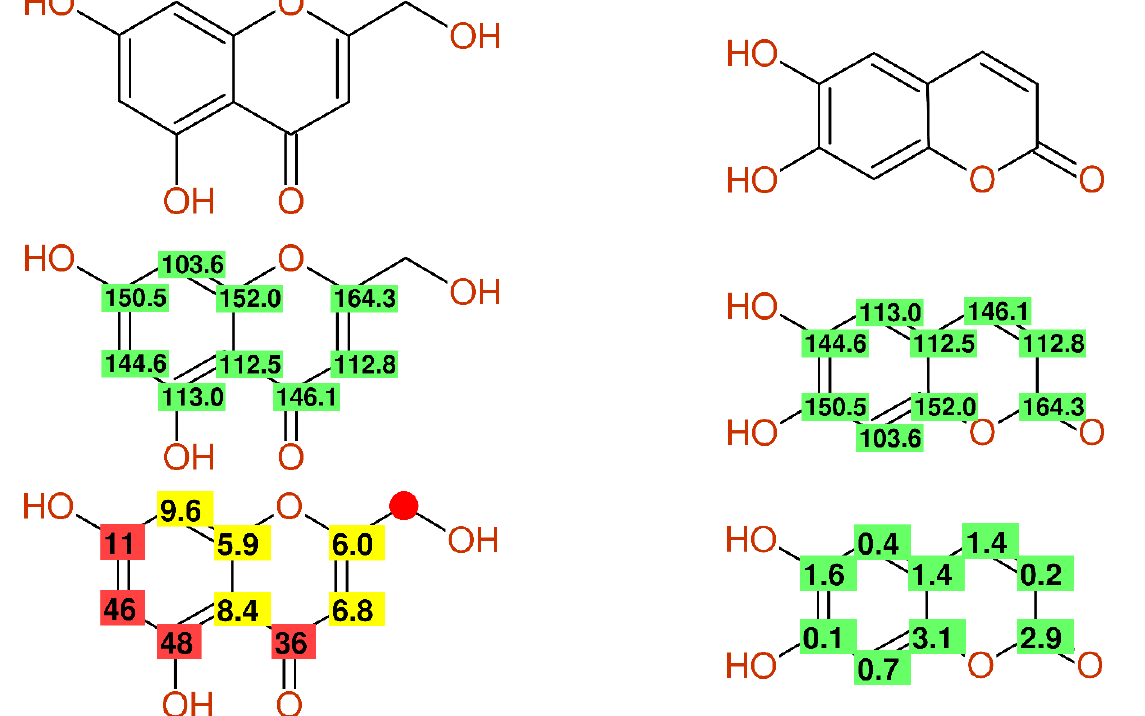
Figure 1. The structures of compound 5 ( left ) and compound 4 ( right ) from [33] together with the published 13 C-NMR data (green, signal assigned by author, and yellow, signal exchangeable assigned) and the differences between experimental and predicted values (cred > 10 ppm, yellow < 10 ppm and >5 ppm, green < 5 ppm).